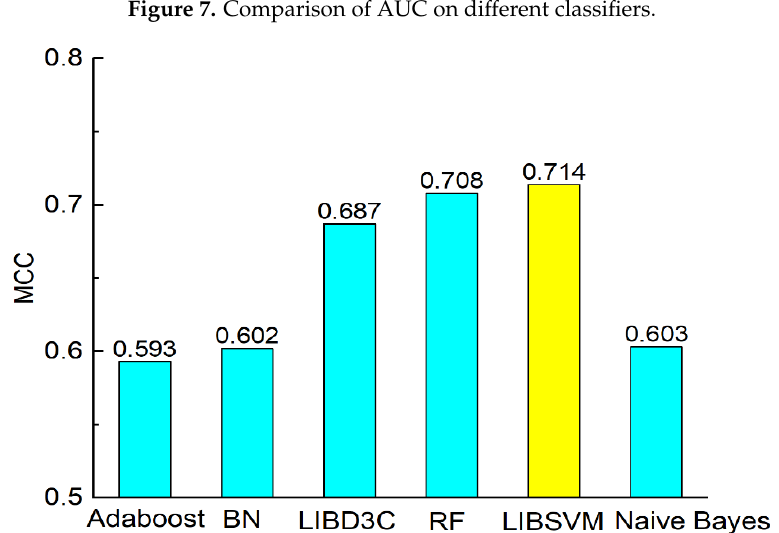
Figure 8. Comparison of MCC on different classifiers.